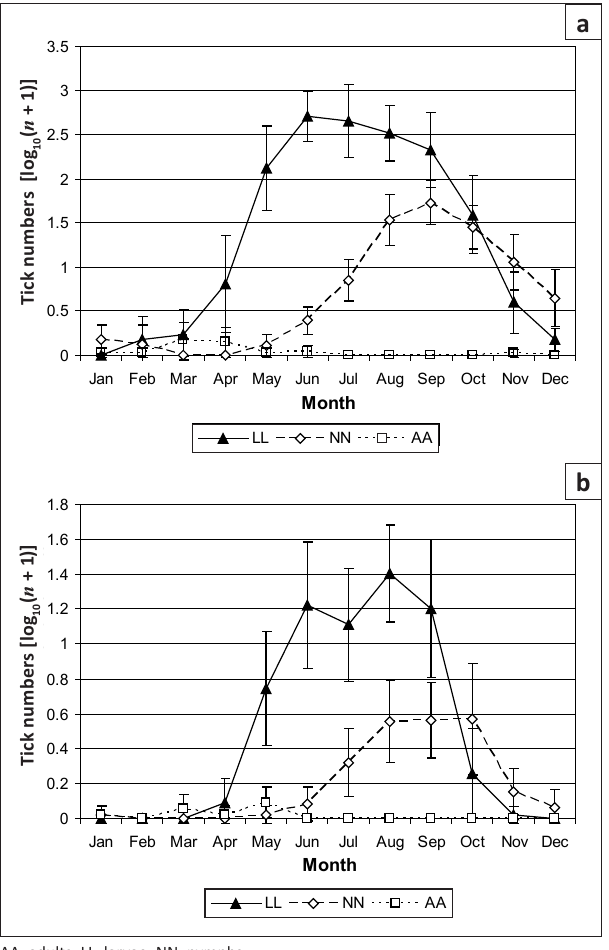
FIGURE 7: Mean (± 95% confidence interval) monthly collections of Rhipicephalus zambeziensis a) larvae and b) nymphs during the active periods per habitat per year at Skukuza.